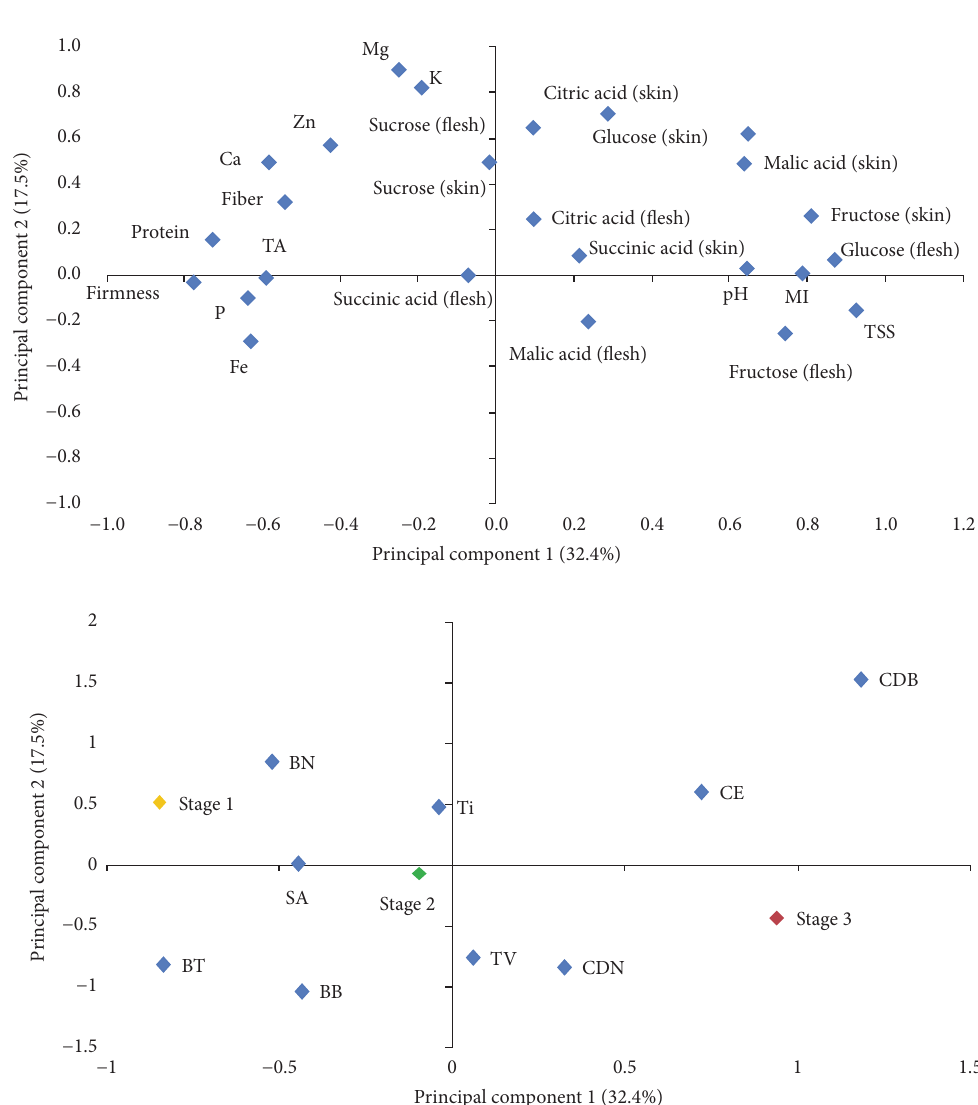
(CDB) for K and from 1.9 (BB) to 3.1 g kg −1 DW (SA) for